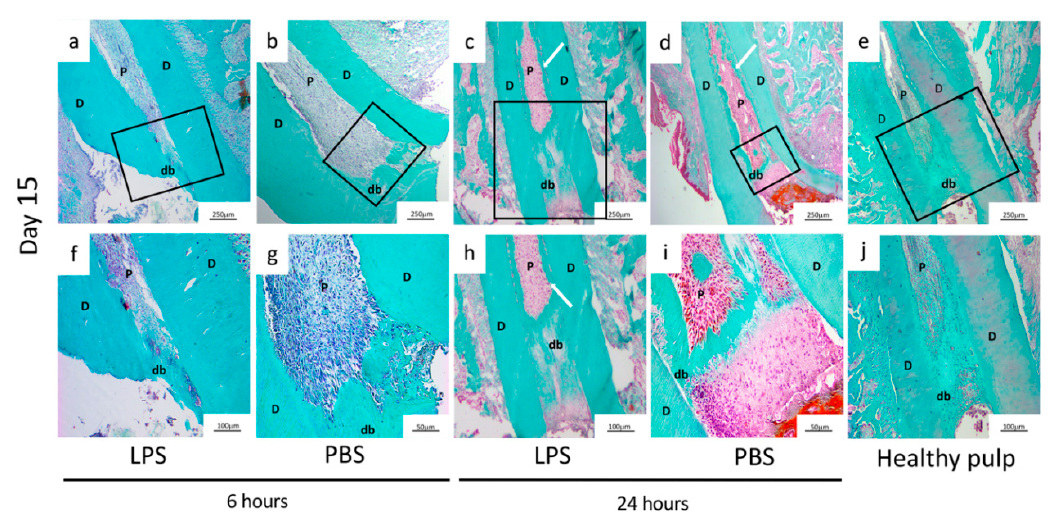
Figure 5. Mineralized bridge evaluation by Masson’s trichrome staining. Masson’s trichrome staining (MTS): ( a – e )